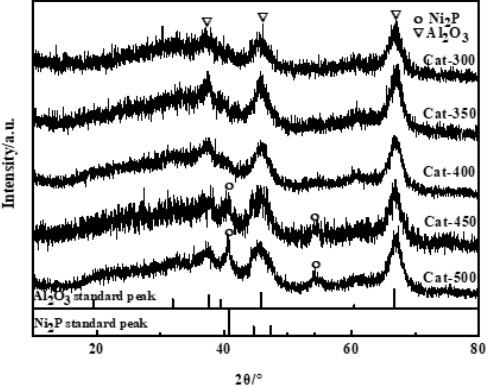
Figure 1. X-ray diffraction spectra of different Ni 2 P/Al 2 O 3